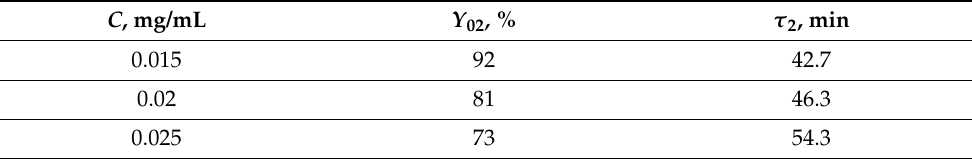
Table 2. The values of pre-exponential factors Y 02 and relaxation times τ 2 for